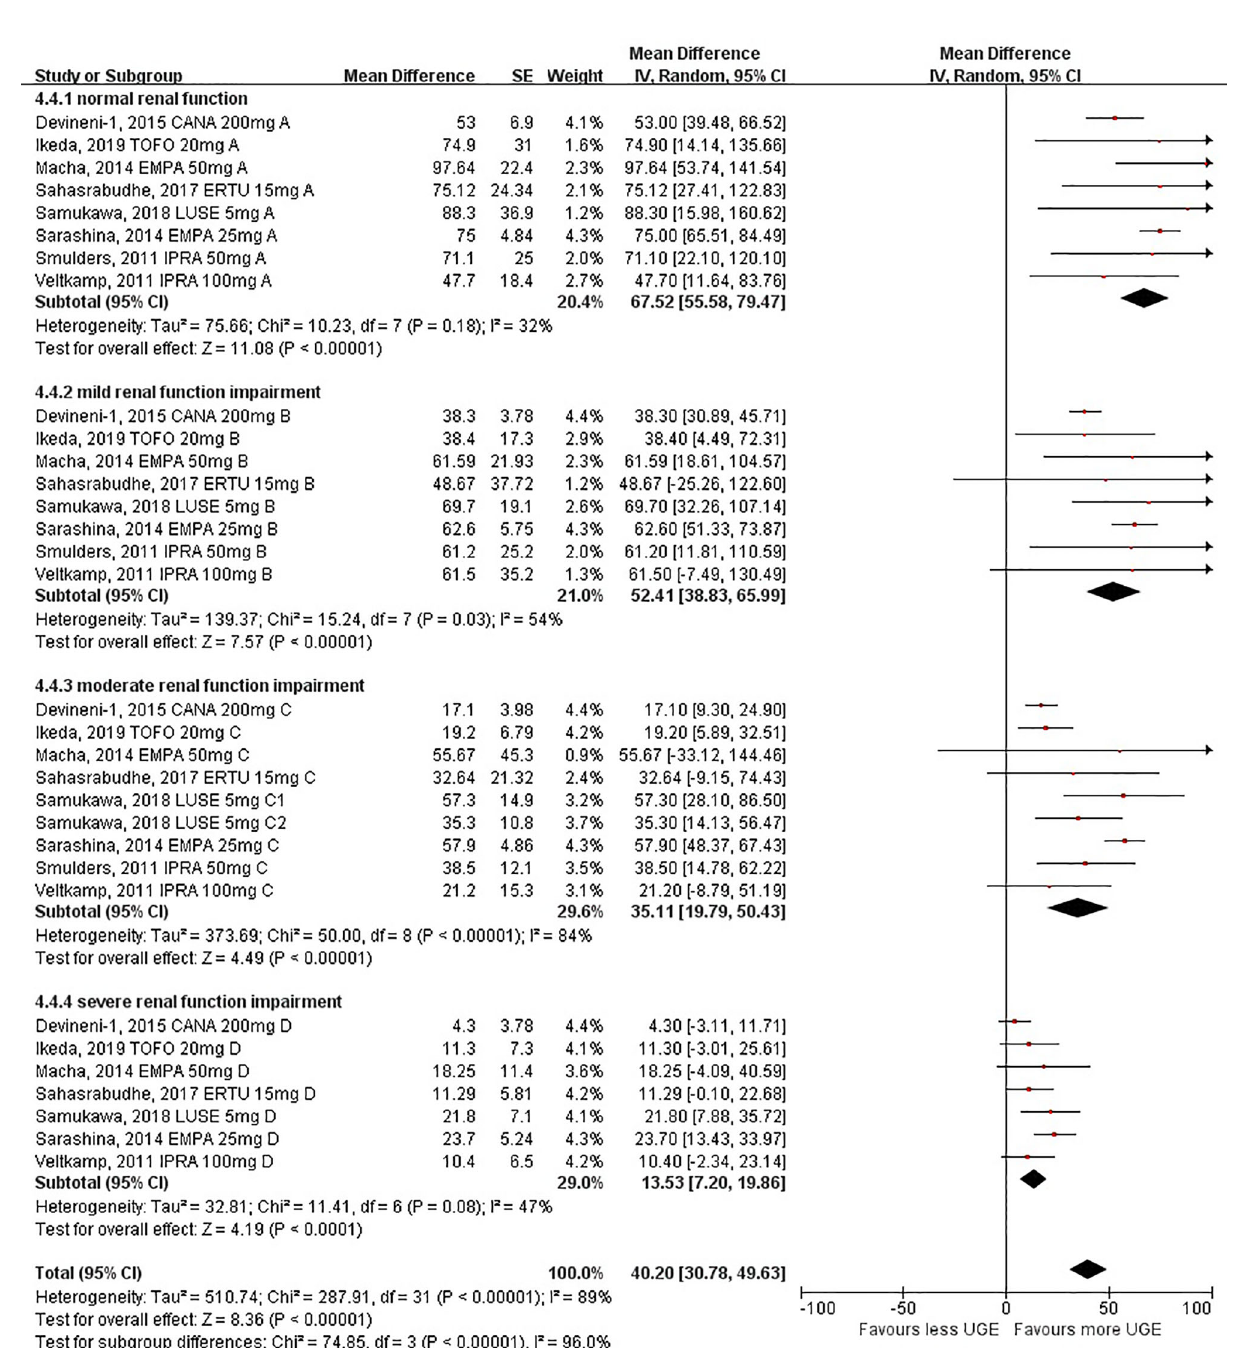
FIGURE 3 | Urinary glucose excretion changes before and after sodium – glucose cotransporter 2 inhibitor treatment in patients with different levels of renal